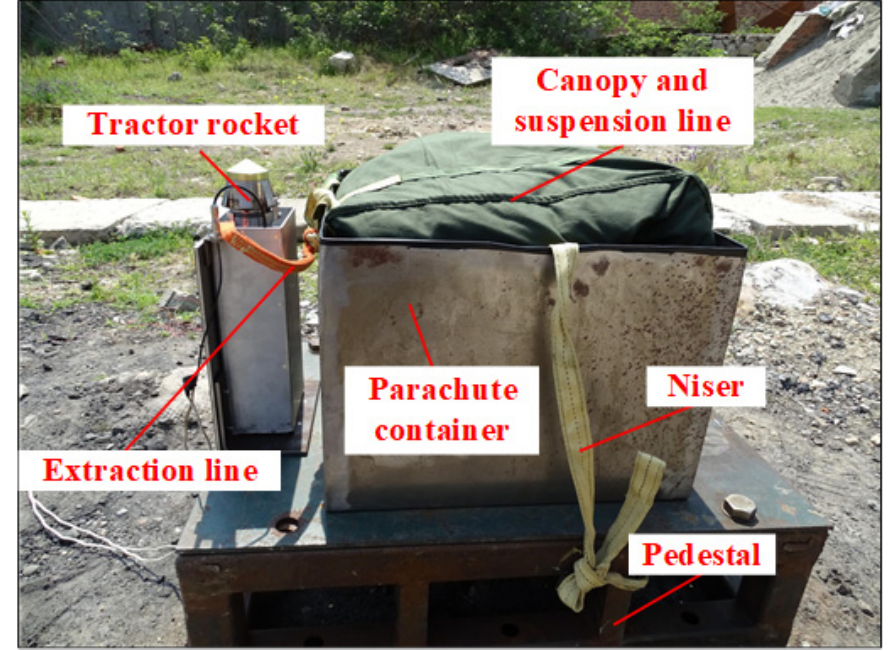
Figure 13. Experiment layout.